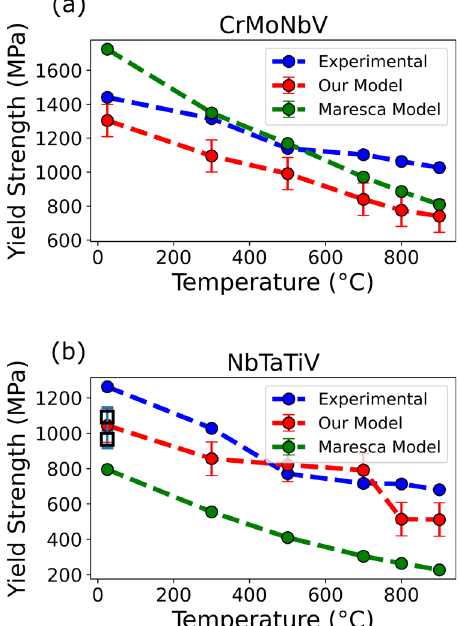
Fig. 3 Validation of machine learning model with unseen experimental data, and comparison of the ML model to the edge dislocation model of Maresca et al. a CrMoNbV, and b NbTaTiV. “ Experimental ” and “ Maresca Model ” data taken from Maresca et al 29 . For NbTaTiV, the black squares indicate the yield strength for the alloy reported by two other references 9,66 . A 95% con fi dence level error (±94 MPa) is shown for Our